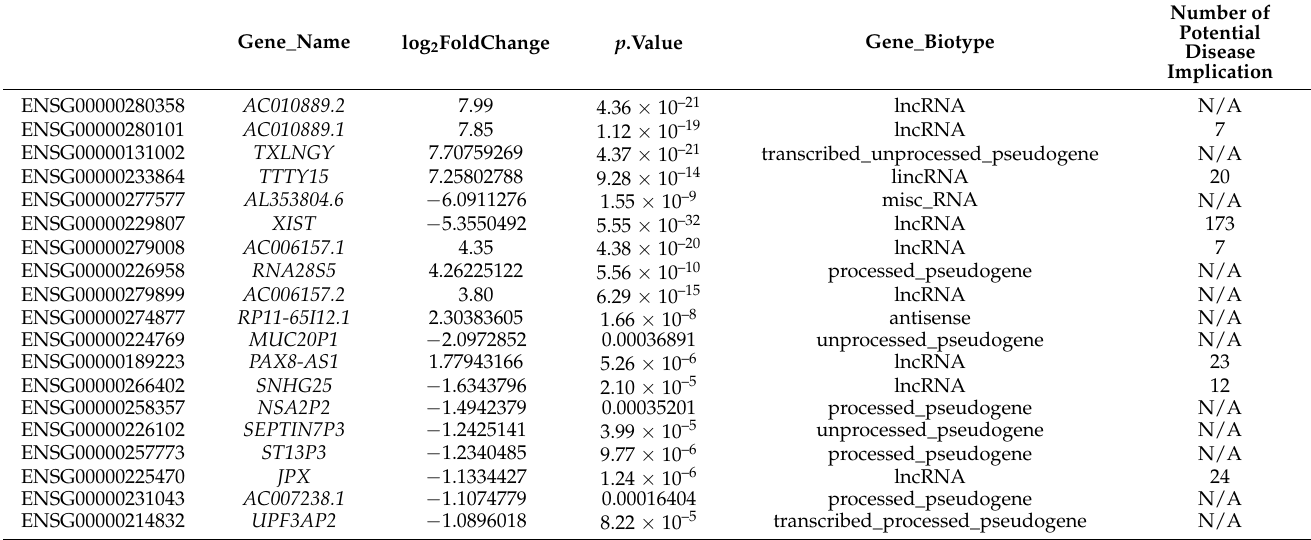
Table 3. nc DE RNAs emerging in OBM vs. OBF SAT, along with the number of diseases in which they are potentially